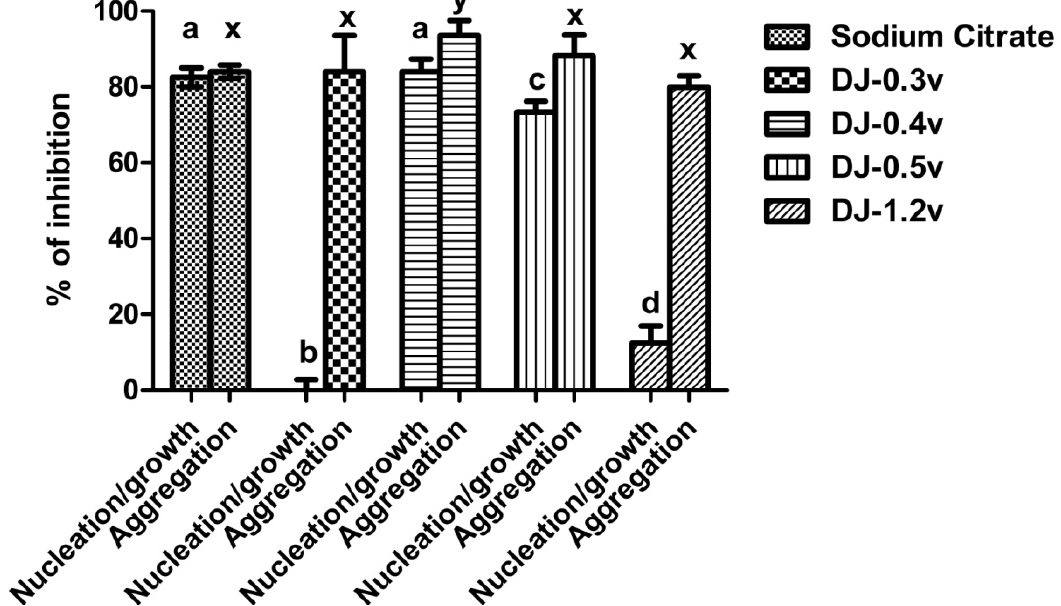
Figure 4. Inhibition crystallization of salts of calcium oxalate activity of sulfated polysaccharides from the brown seaweed D. justii . Different letters ( a , b , c , d , x ) indicate a significant difference ( p < 0.05) between 0.25 mM of sodium citrate and different